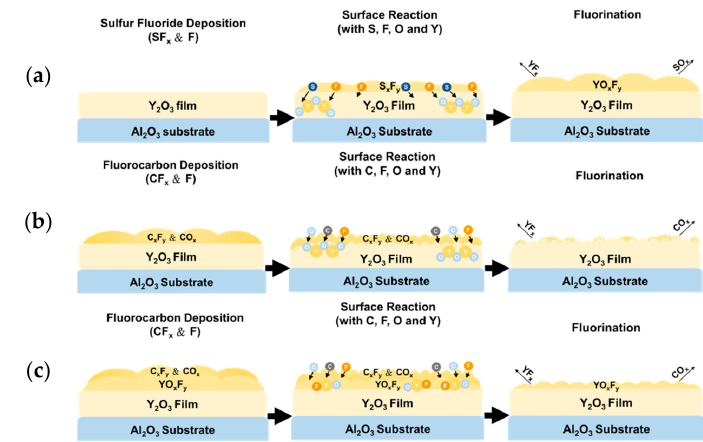
Figure 7. Schematic of the SF 6 plasma-treated films, and suggested mechanism of the CF 4 /O 2 plasma-etching behavior on the as-deposited Y 2 O 3 and SF 6 plasma-treated films. ( a ) SF 6 plasma-treated Y 2 O 3 ; (b) as-deposited Y 2 O 3 after CF 4 /O 2 etching; ( c ) SF 6 plasma-treated Y 2 O 3 after CF 4 /O 2 etching.